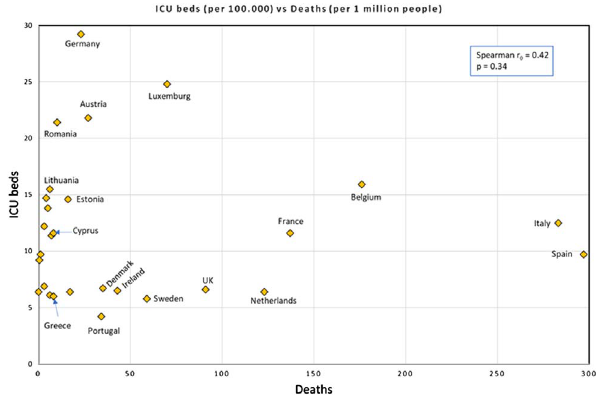
Figure 1. A statistical review of ICU beds (per 100,000) versus deaths (per 1 million people) in European